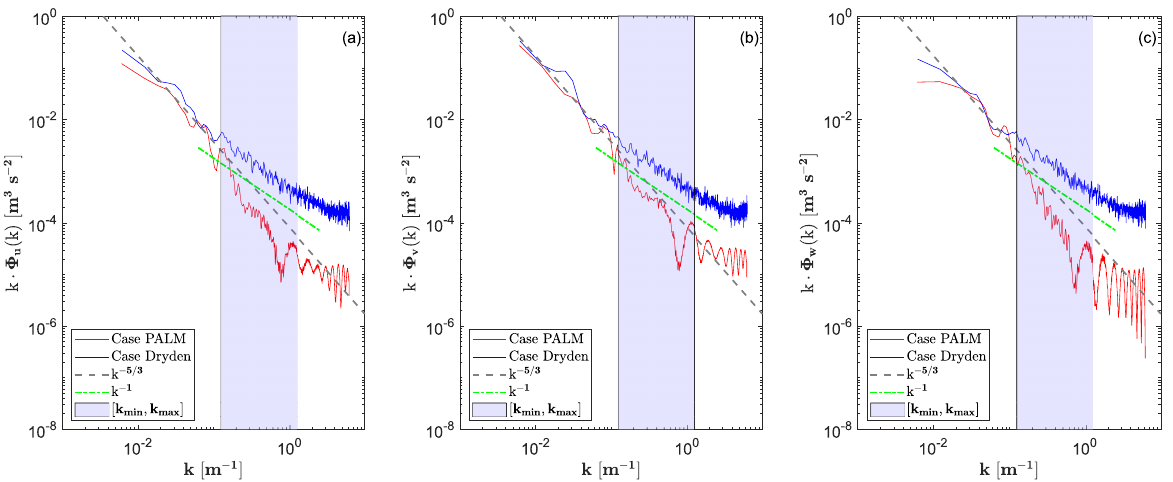
Figure 18. Spectra of wind velocity component ( a ) u , ( b ) v and ( c ) w , derived from flight simulation output data of scenario Passo del Bernina at an average altitude of 10,500 ft (3200 m). The grey dashed line represents the reference − 3/5-slope according to Kolmogorov’s law [71]. The dashed dot green line denotes the reference − 1-slope. The box in light blue shading indicates the time frame of interest for the flight simulation experiment, which is determined by the lower limit wave number k min of 2 π /50 m − 1 and the high limit wave number k max of 2 π /5 m − 1